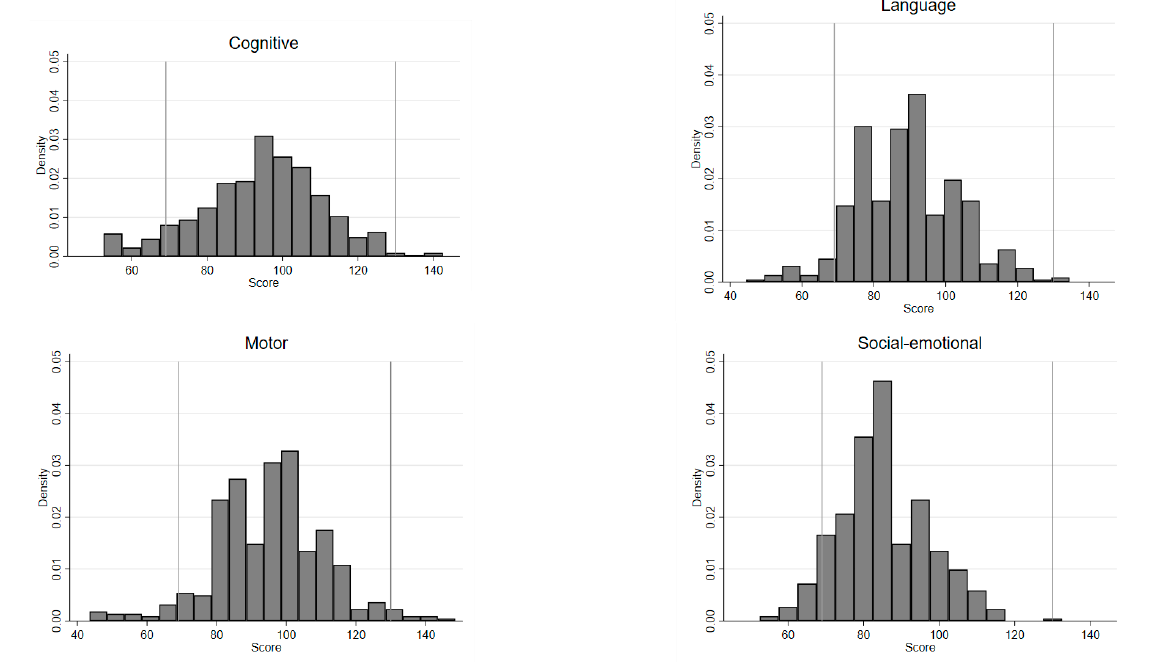
Figure 1. Density distribution of BSID-III composite scores.